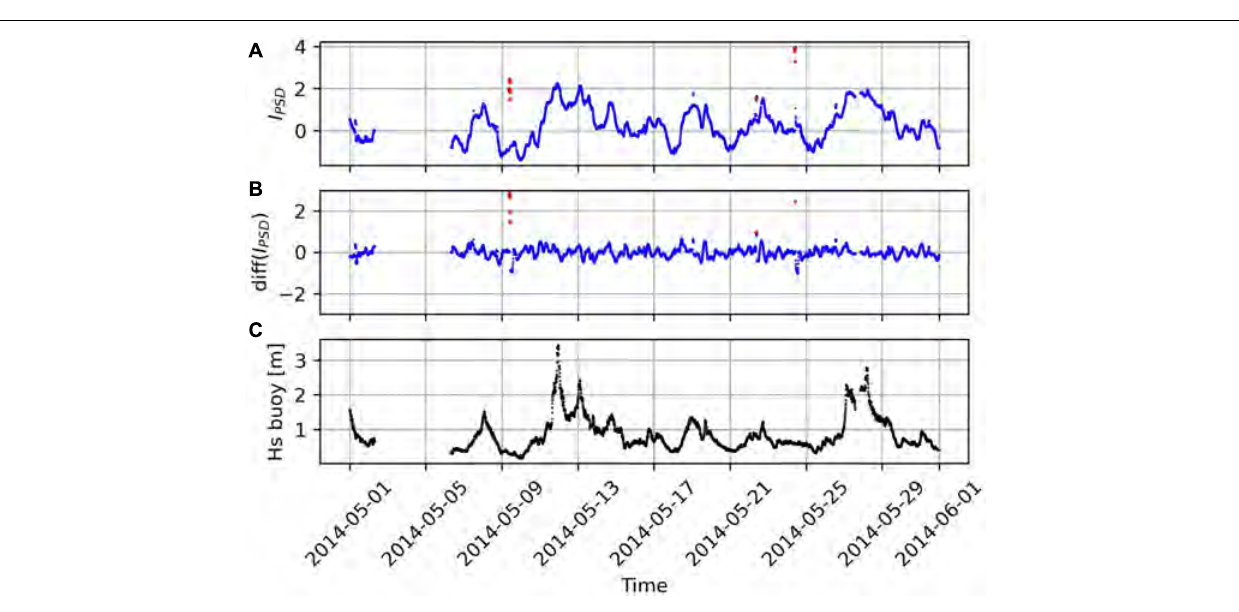
FIGURE 8 | Time plots of (A) I PSD , (B) diff(I PSD ) (as defined in the section “Data Pre-processing and Cleaning”), and (C) H s . Anomalies are in